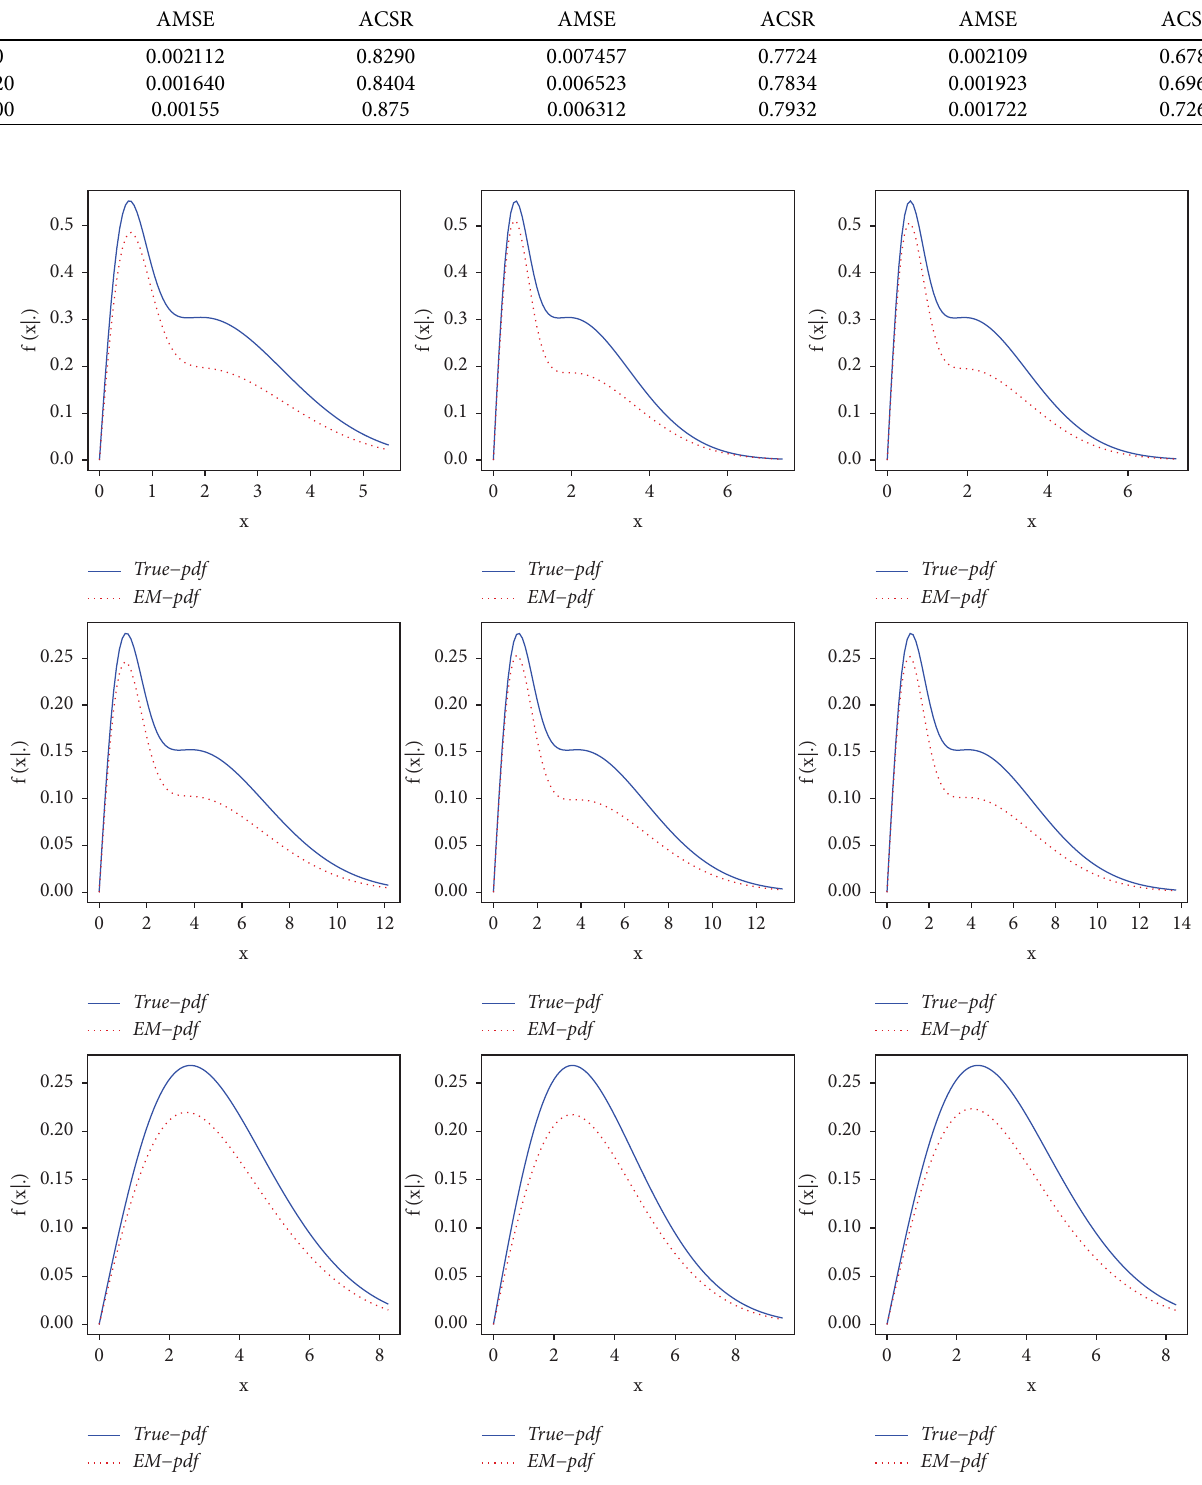
Figure 1: Te graphs of the PDF of the model for true parameters and estimated ones by the EM algorithm. Te columns of graphs represent the sample sizes n � 90, 120, and 200, respectively. Te rows of graphs represent the parameter scenarios ( π 1 , θ 1 , θ 2 ) � (0.35, 1, 4), (0.35, 0.5, 2), and (0.25, 2, 3), respectively.